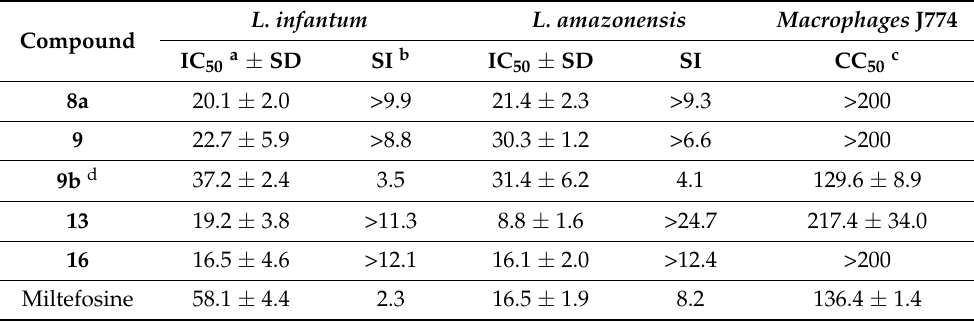
Table 2. Antileishmanial and cytotoxicity (IC 50 in µ M) of C19-functionalized ferruginol and sugiol analogs on amastigotes. L. infantum L. amazonensis Macrophages J774 Compound IC 50 a ± SD SI b IC 50 ± SD SI CC 50 c 8a 20.1 ± 2.0 >9.9 21.4 ± 2.3 >9.3 >200 9 22.7 ± 5.9 >8.8 30.3 ± 1.2 >6.6 >200 9b d 37.2 ± 2.4 >11.3 >24.7 217.4 ± 34.0 >12.1 16.1 ± 2.0 >12.4 >200 Miltefosine 58.1 ± 4.4 2.3 16.5 ± 1.9 8.2 136.4 ±